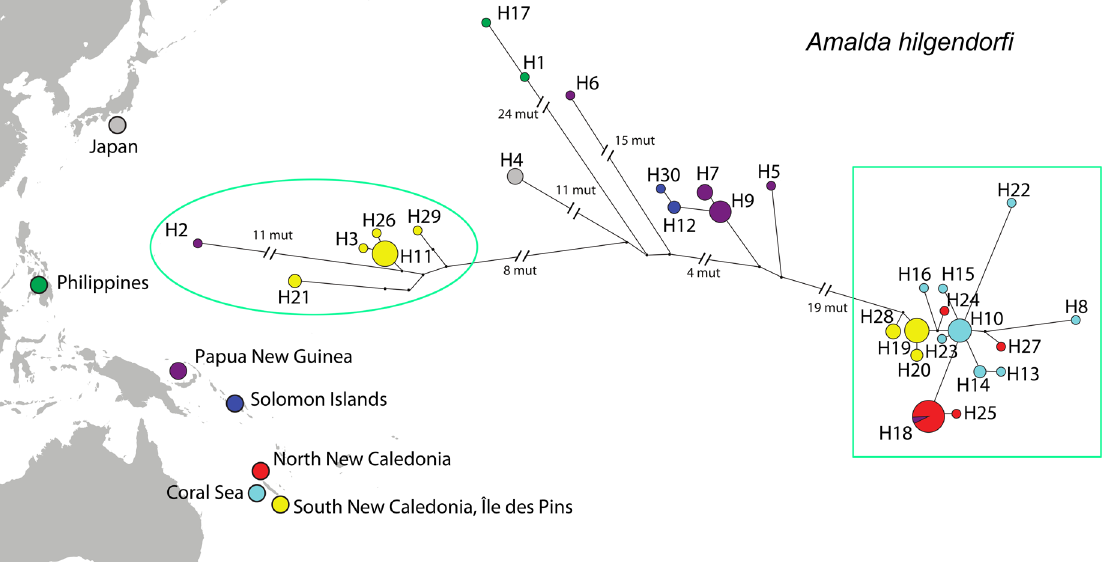
Fig. 3. Median-joining haplotype network based on Cox1 sequences of Amalda hilgendorfi (von Martens, 1897). Circles are colour coded by general location reported on the map and sized according to each haplotype’s relative abundance. Lengths of the lines connecting haplotype circles are proportional to the number of nucleotide differences among haplotypes. Green rectangle and oval encircle assemblages of haplotypes from New Caledonia (each including a specimen from Papua New